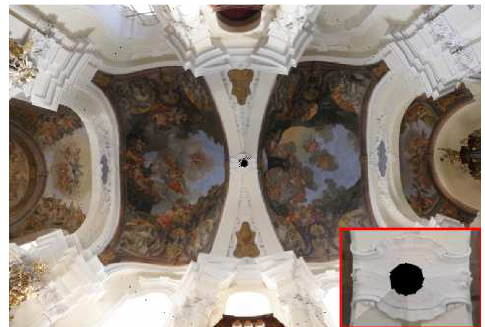
Figure 4. Faulty stitched panoramic image with GigaPan Software